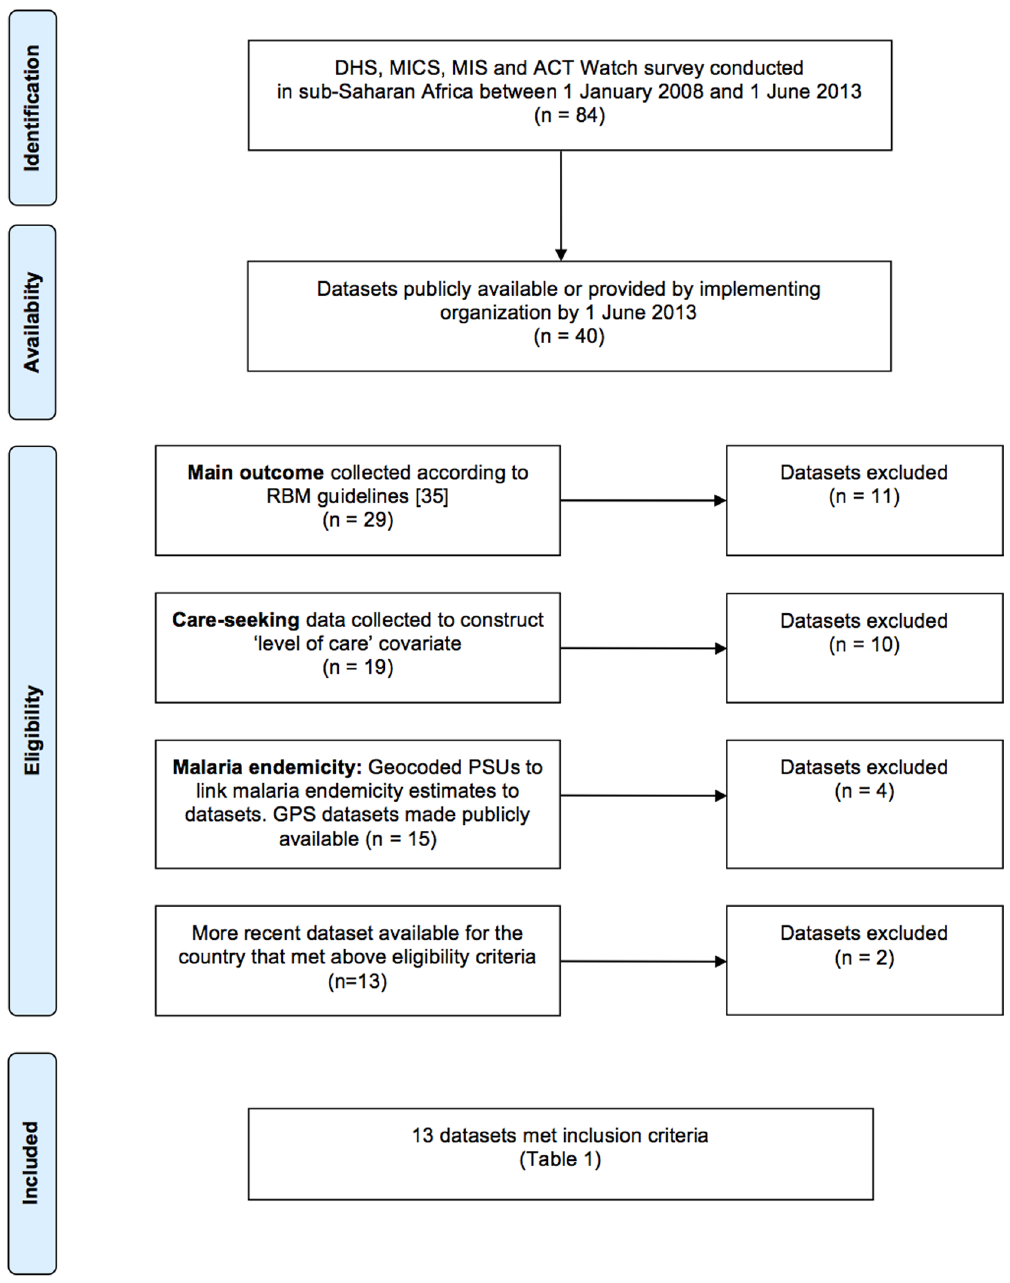
Figure 1. Flow chart of inclusion criteria for study.